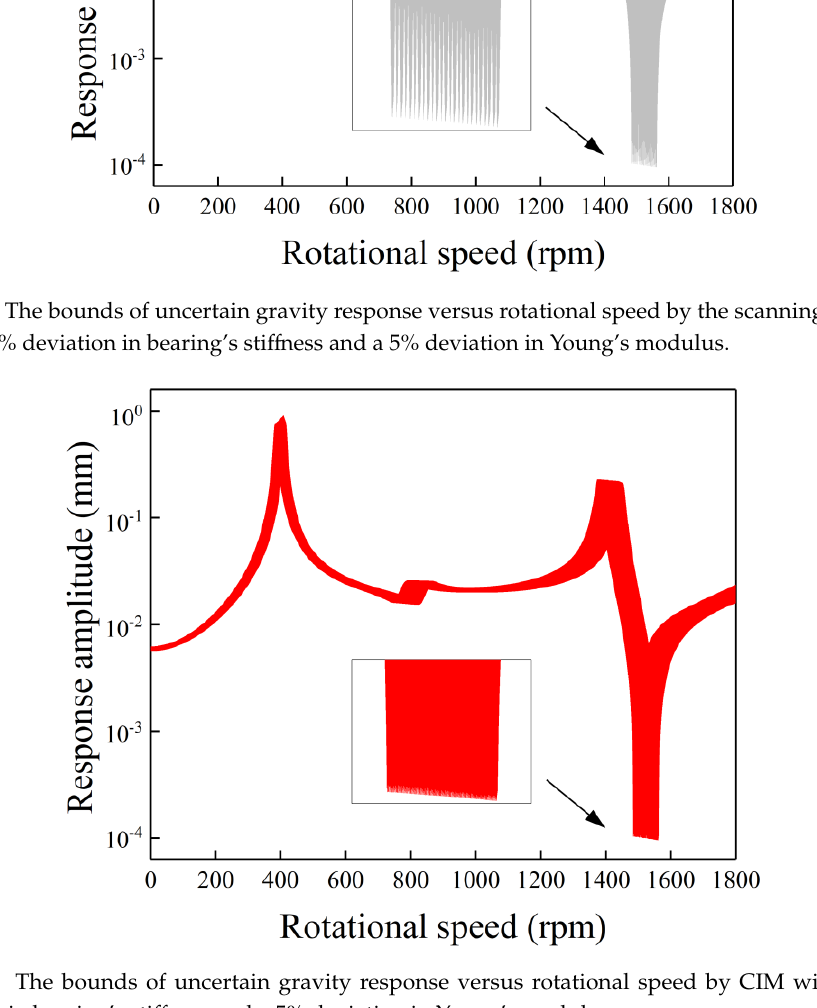
Figure 10. The bounds of uncertain gravity response versus rotational speed by CIM with a 5% deviation in Young’s modulus and a 5% deviation in density. 4. Conclusions